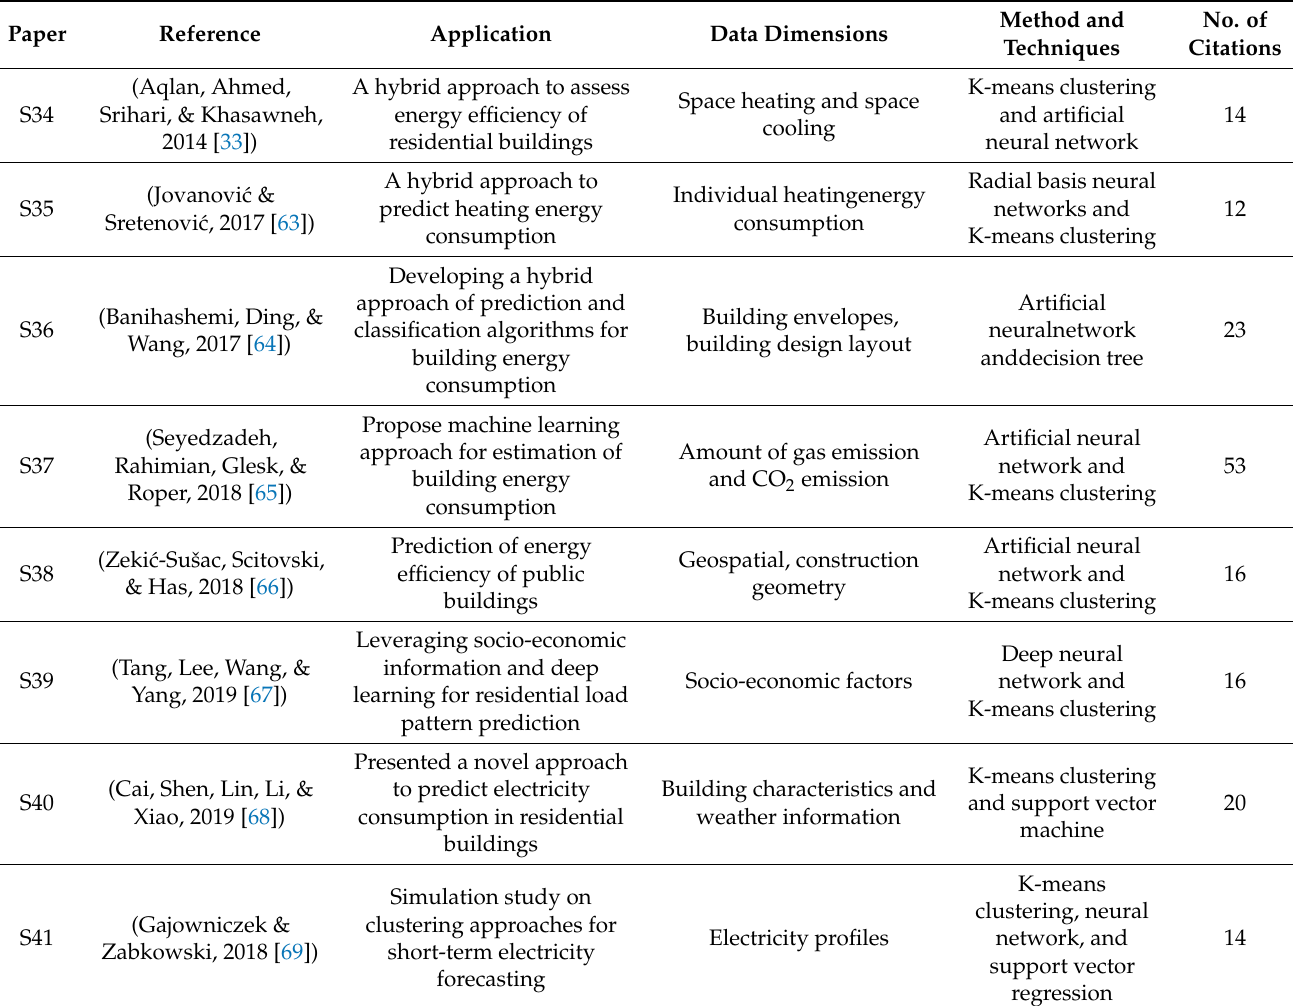
Table 4. Summary of papers in the category of combination of classification and prediction of energy consumption of